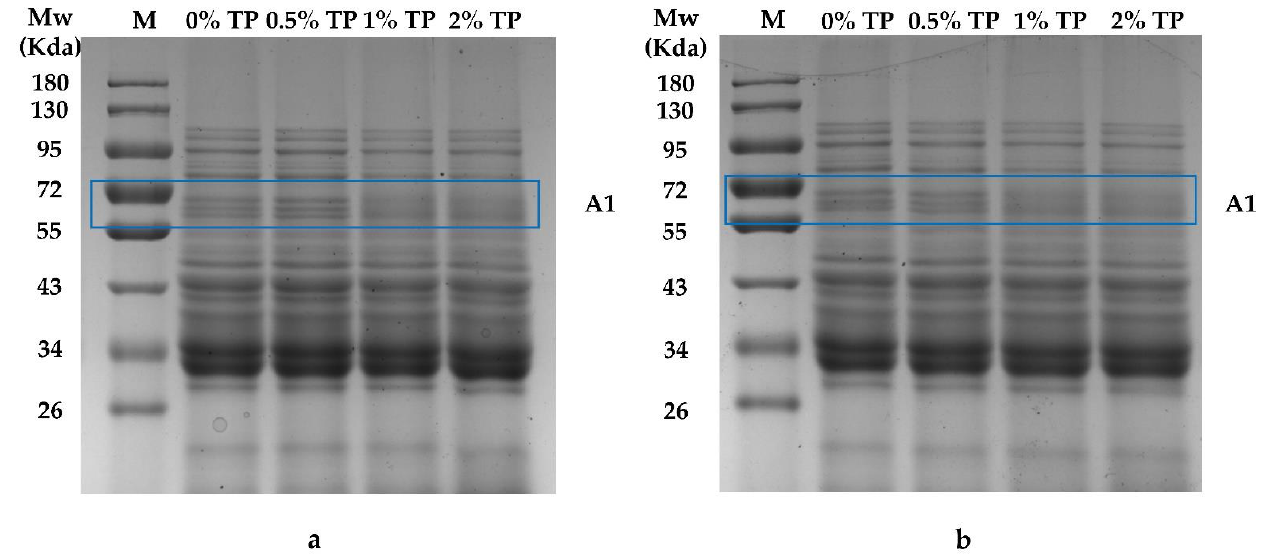
Figure 3. SDS-PAGE patterns of NFFD with 0–2% TP at 0 ( a ) and 4 ( b ) weeks. M, molecular weight of standard; A1, Area 1.